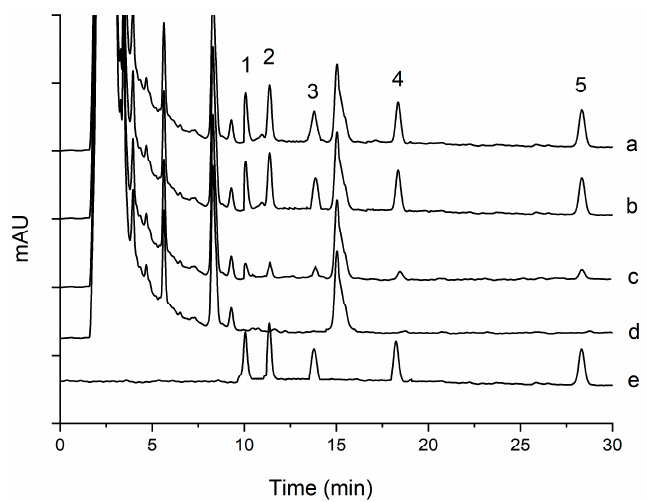
Figure 8. Typical chromatograms of five pyrethroids in oral shengmaiyin liquids under optimum conditions: (1) transfluthrin, (2) fenpropathrin, (3) fenvalerate, (4) etofenprox, and (5) silafluofen. In chromatograms (a, c, d), the spiked levels are 100, 20, and 0 ng mL − 1 , and (b, e) show the standard solution in blank matrix and acetonitrile.